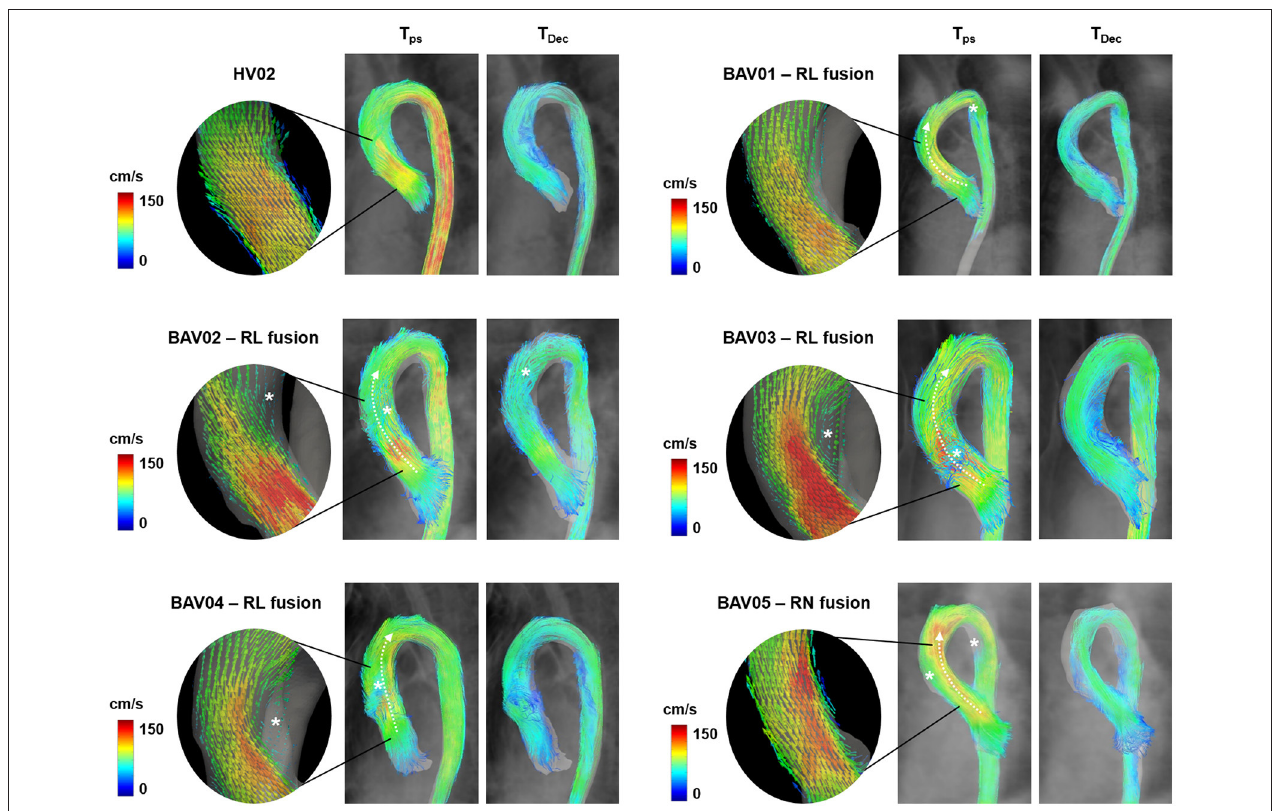
FIGURE 4 | Visualization of 3D blood flow streamlines within the aortic lumen at the time-frames corresponding to peak-systole (T ps ) and to mid-deceleration phase (T Dec ). In rounded panels, the features of blood flow jet across the aortic valve during systolic ejection are highlighted through vectors projected on a long-axis view of the left ventricle outflow tract. White asterisks are reported in presence of macroscopic altered secondary flows.